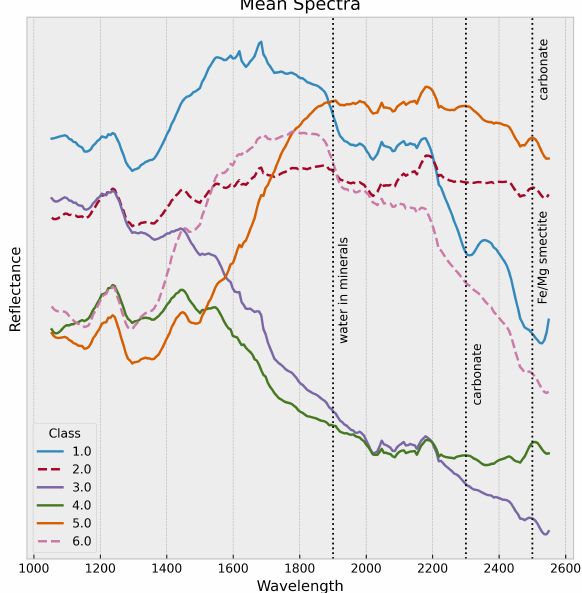
Figure 6. Mean spectra per cluster as representative fingerprint. Key unique absorptions at 1900 nm (water in minerals), 2300 nm and 2500 nm (carbonate) and 2300 nm (Fe/Mg smectite) are marked with vertical dotted